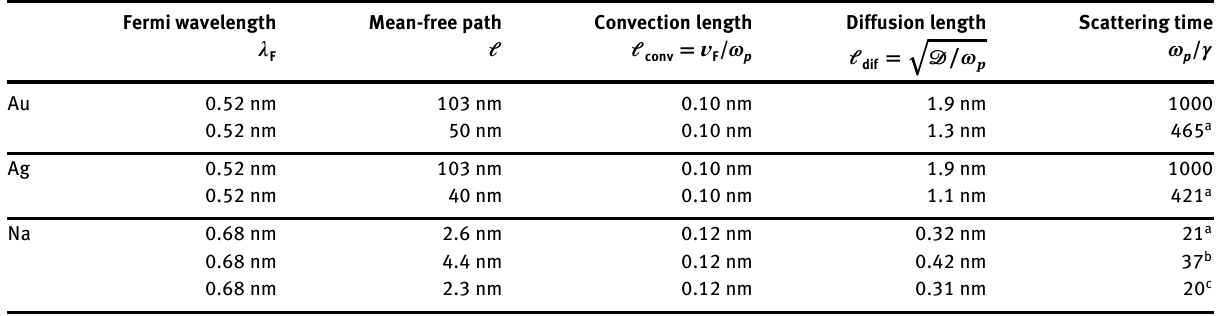
Table 1: Central length scales and parameters for gold (Au), silver (Ag), and sodium